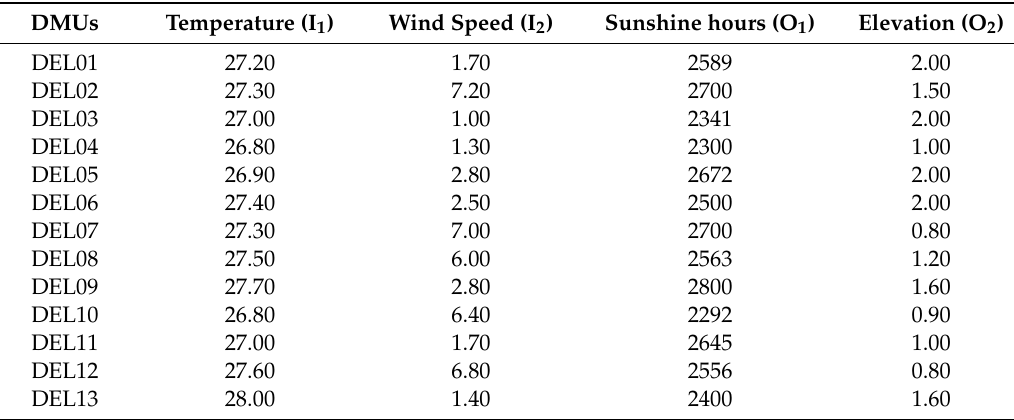
Table 5. Raw data of DEA model.